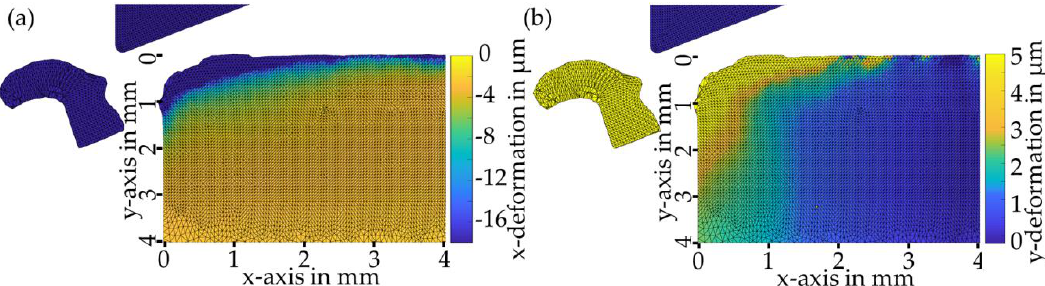
Figure 10. Simulated remaining modifications in the form of deformations: ( a ) x-deformation and ( b ) y-deformation.